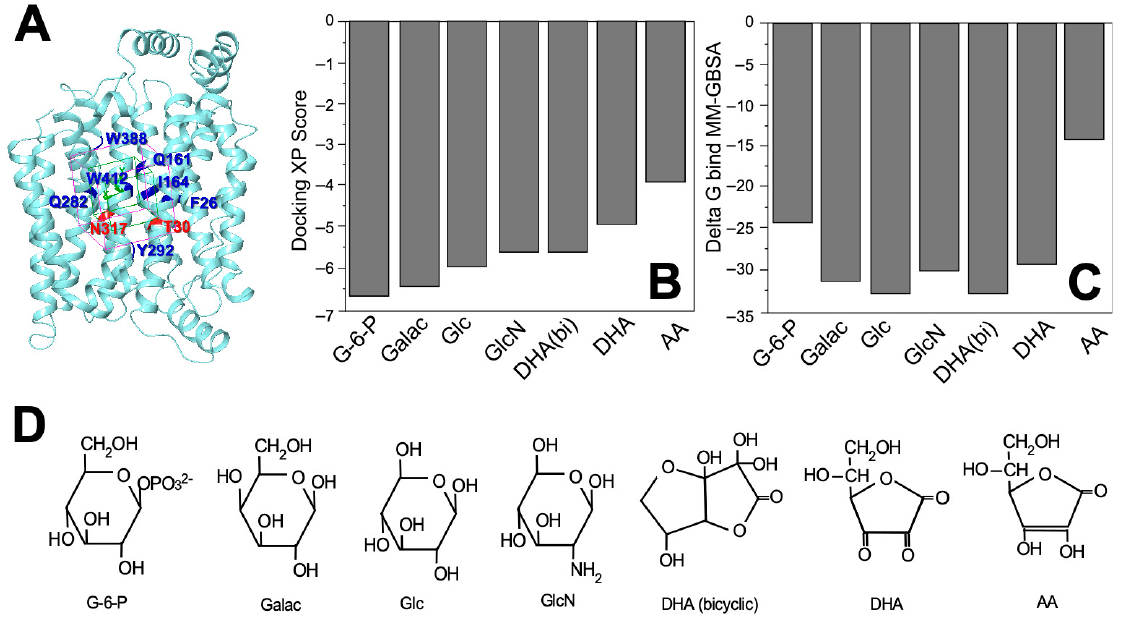
Figure 2. Interactions between GLUT1 and the different substrates as predicted by protein-ligand docking. ( A ) Position of the 5 Å grid interaction (purple box) used for docking simulations with the amino acids that are part of the sugar-binding sites indicated in blue and red; ( B ) Docking XP scores for the seven molecules capable of forming a stable complex with GLUT1 (i.e., glucose-6-phosphate, D-galactose, D-glucose, D-glucosamine, dehydroascorbic acid, bicyclic dehydroascorbic acid, and ascorbic acid); ( C ) Theoretical ∆ G bind values for the seven molecules analyzed with data expressed in kcal/mol and estimated using the MM-GBSA method; ( D ) Structure of the seven molecules analyzed in this study. G-6-P: glucose-6-phosphate; Galac: D-galactose; Glc: D-glucose; GlcN: D-glucosamine; DHA (bicyclic): dehydroascobic acid bicyclic form; DHA: dehydroascorbic acid; AA: ascorbic